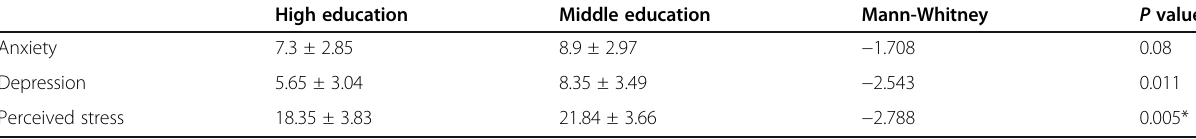
Table 4 Education level in relation to anxiety, depression, and perceived stress after weight